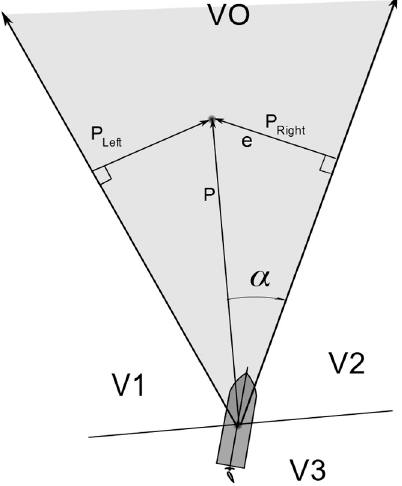
Figure 9. Illustration of the velocity obstacle (VO) regions.